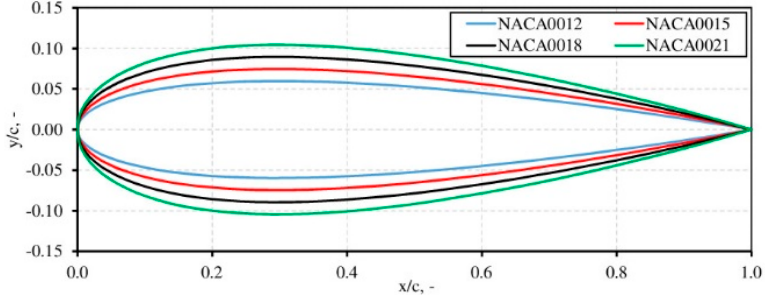
Figure 5. Investigated NACA airfoils.